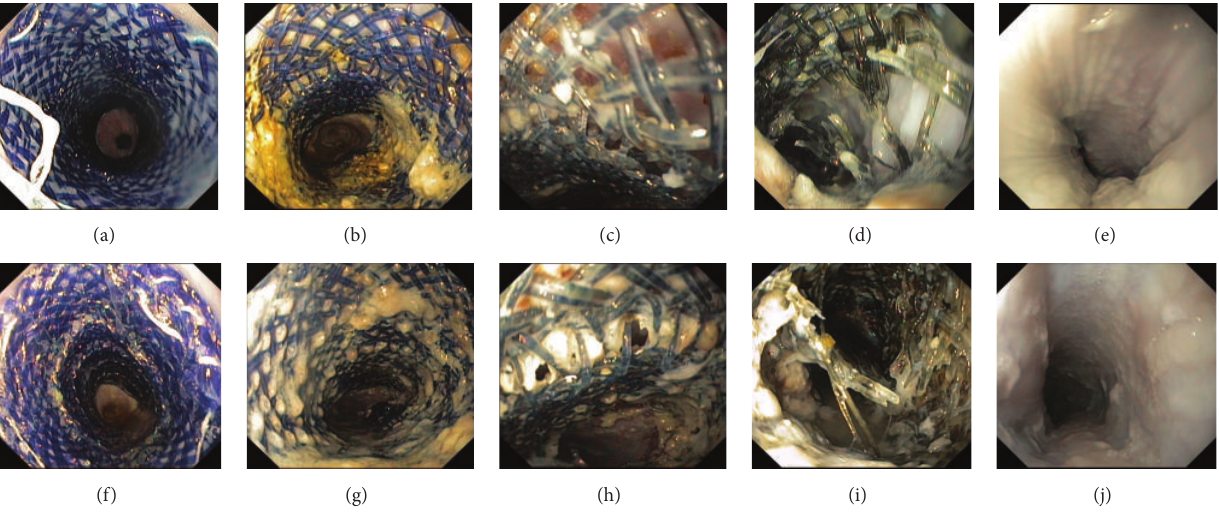
Figure 3: Endoscopic view of degradation procedures of an uncovered biodegradable stent ((a)–(e)) and a fully covered biodegradable stent ((f)–(j))invivo.(a)Week0:immediatelyafteranuncoveredstenttransplantation.(b)Week1afterstenttransplantation:nosignofdegradation was present. (c) Week 3: larger stent meshes and partial separation of the stents from the esophageal wall at the stent trunk were present. (d) Week 8: stent structure breakage occurred. (e) Week 9: complete stent degradation of an uncovered biodegradable stent. (f) Week 0: immediately after a fully covered stent transplantation. (g) Week 1 after stent transplantation: no sign of degradation was present. (h) Week 3: larger stent meshes, partial separation of the stents from the esophageal wall at the stent trunk, and poly-L-lactic acid membrane fracture were present. (i) Week 9: stent structure breakage occurred in a fully covered biodegradable stent. (j) Week 10: complete stent degradation of a fully uncovered biodegradable stent.